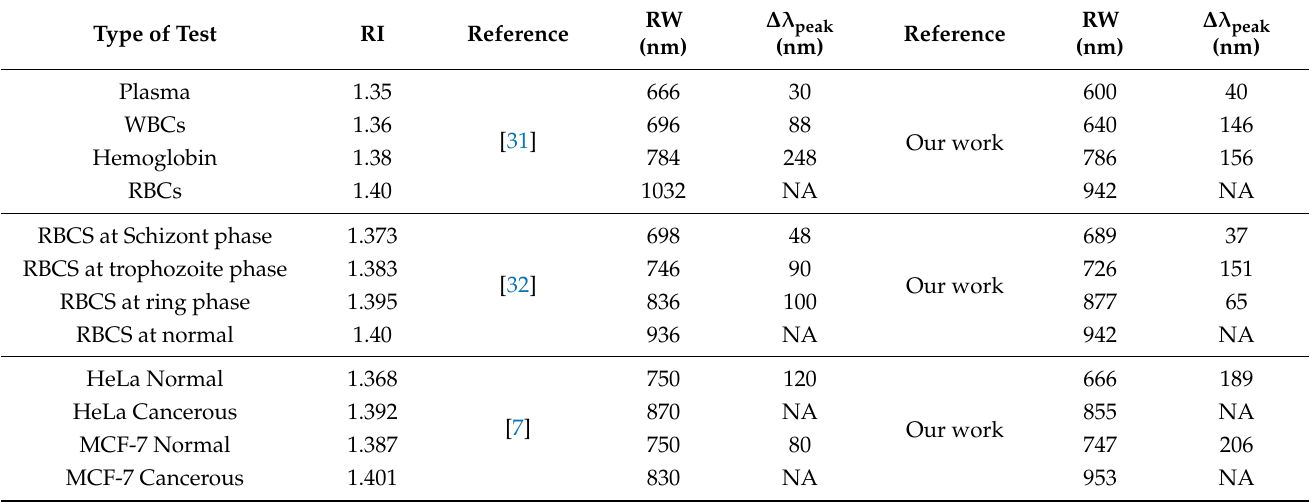
Table 4. Bioinformatic detection comparison of the proposed multi-channel sensor with the existed